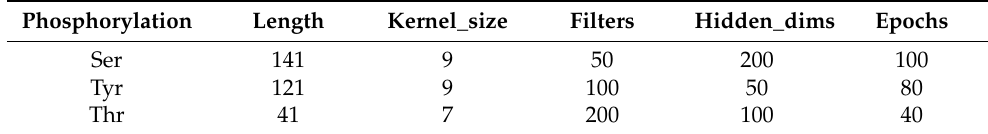
Table 1. The optimal parameters of CNN models by 10-fold cross validation.